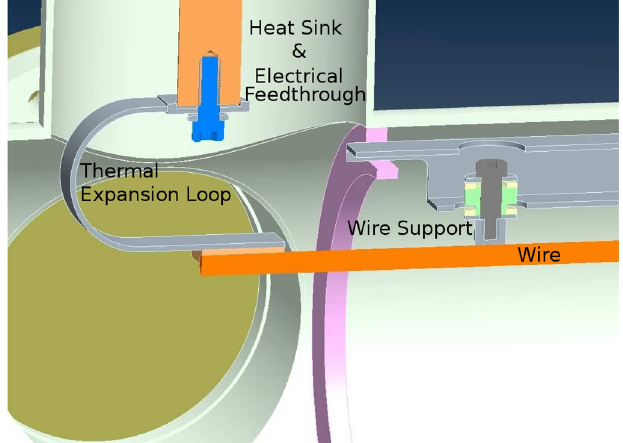
FIG. 6. Drawing of the end of a long-range beam-beam wire in